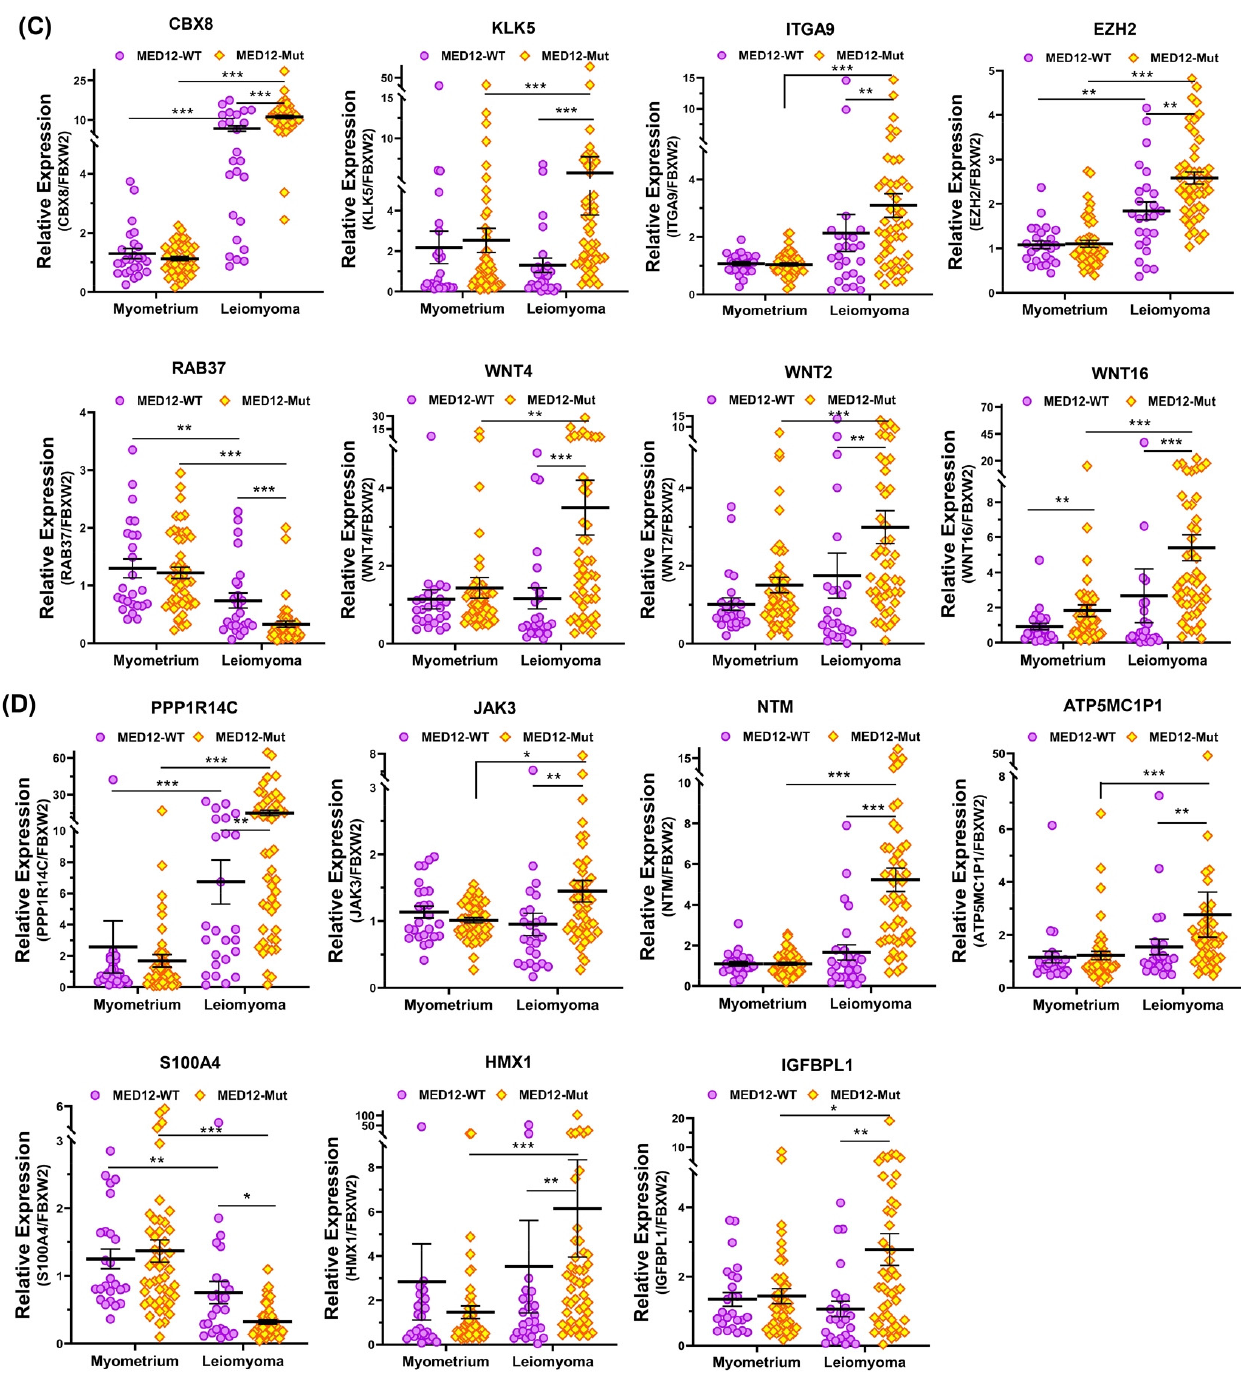
Figure 6. The expression of mRNA for ( A ) CYP19A1, RGS4, BMP7, COL11A1, DCX, CACNA1D, MTMR8, and FCGBP; ( B ) MUC12, FRMD5, WIF1, CXCL13, EGFL6, FN1, S100A1, and NDC80; ( C ) CBX8, KLK5, ITGA9, EZH2, RAB37, WNT4, WNT2, and WNT16; ( D ) PPP1R14C, JAK3, NTM, ATP5MC1P1, S100A4, HMX1, and IGFBPL1 in MED12-mutated leiomyomas (n = 48) and non-mutated leiomyomas (n = 25) and myometrium adjacent to MED12-mutated (n = 48) or non-mutated leiomyomas (n = 25) measured using qRT-PCR. The results are presented as mean ± SEM with p values (* p < 0.05; ** p < 0.01; *** p < 0.001) as indicated by the corresponding lines.